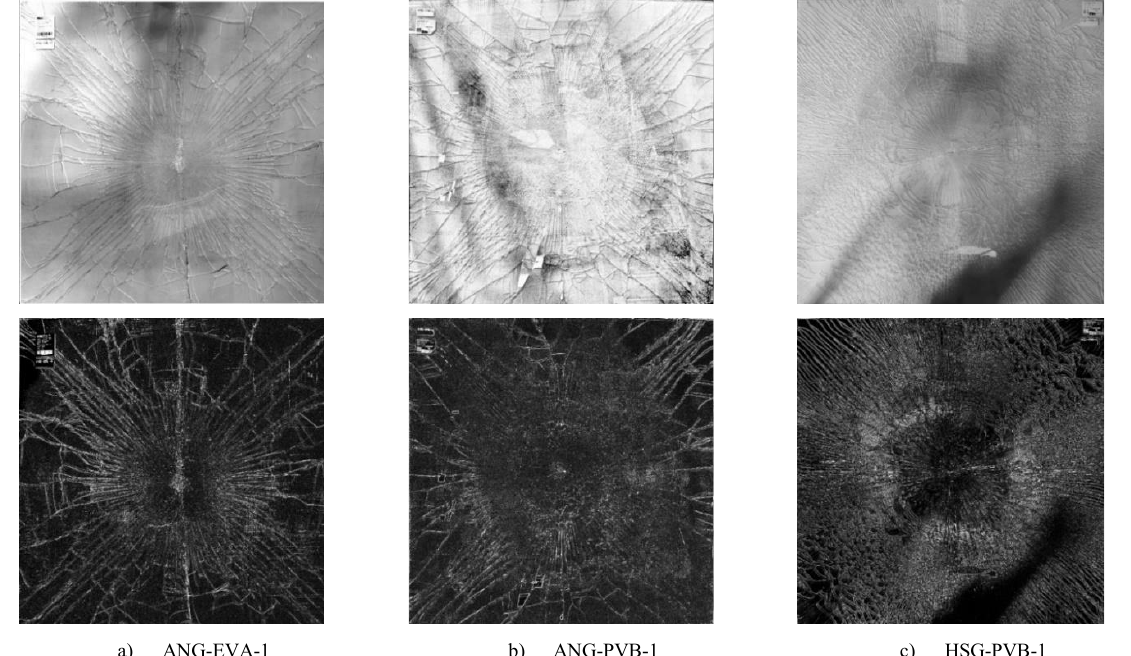
Fig. 9 Photos of laminated glass samples after fracture and fracture pattern using an edge detection